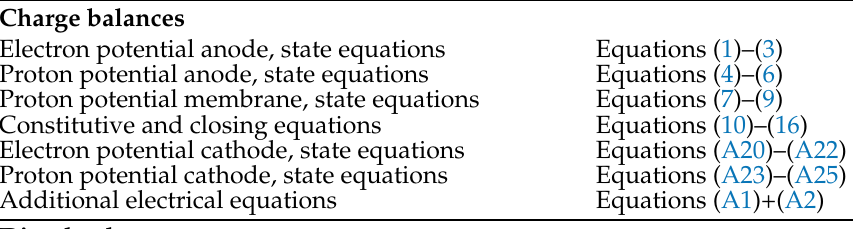
Table 1. Overview on the model equation